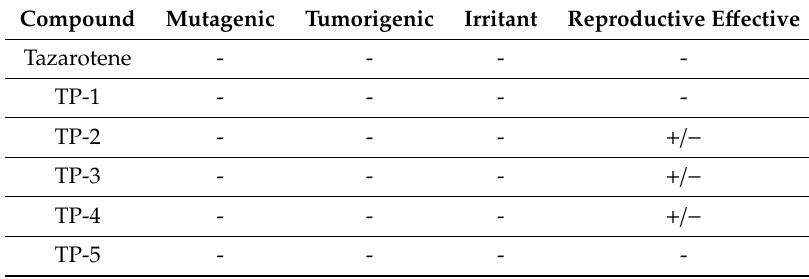
Table 3. Toxicity risk assessment of the photocatalytic degradation products of tazarotene (TP-1–TP-11) performed using OSIRIS Property Explorer.